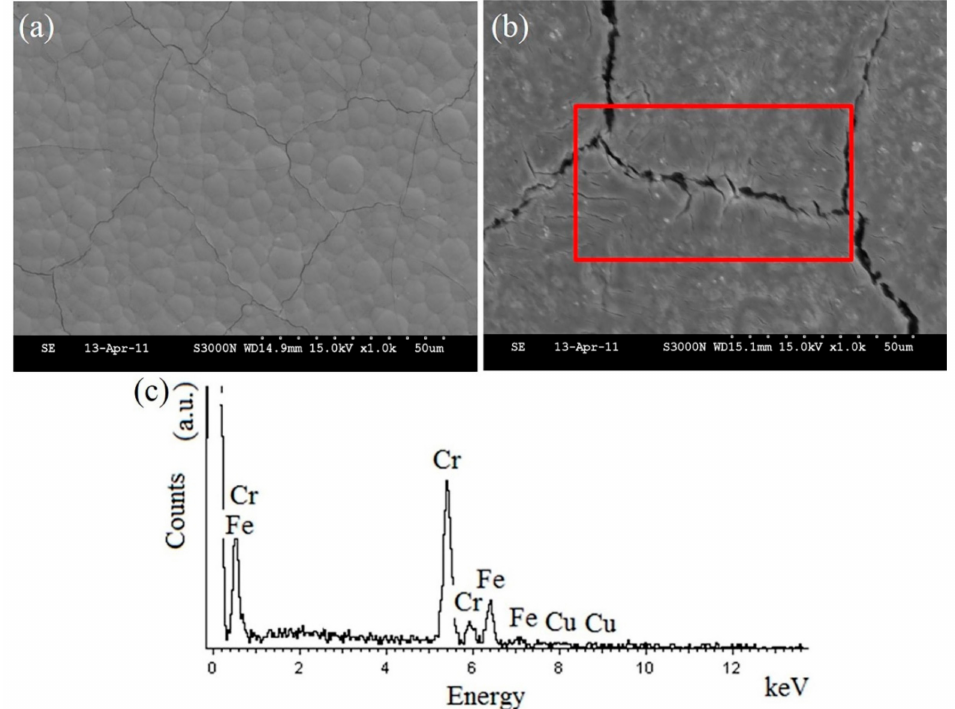
Figure 9. Surface morphologies of the ( a ) non-heated and ( b ) heat-hardened Cr–C / Cu-coated samples after potentiostatic etching at 0.5 V in 0.1 M H 2 SO 4 + 1 g / L NaCl solution; ( c ) energy-dispersive X-ray spectrometer (EDS) analysis of Figure